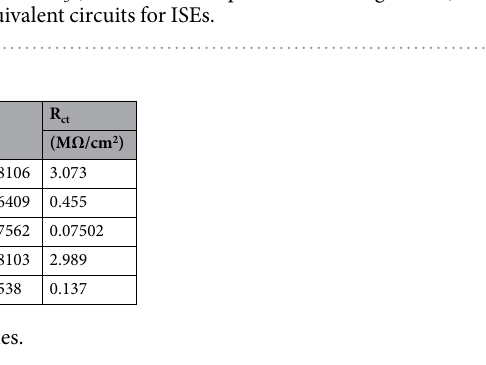
Figure 2. ( a ) Impedance spectra of all ISEs in 0.1 M KNO 3 (the solid lines represent the fitting curves). Inset: partial enlargement of high frequency part. ( b ) Equivalent circuits for ISEs.